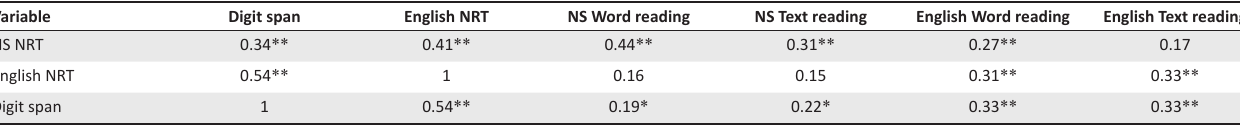
TABLE 3: Correlations between NRT, PWR and reading. Variable Digit span